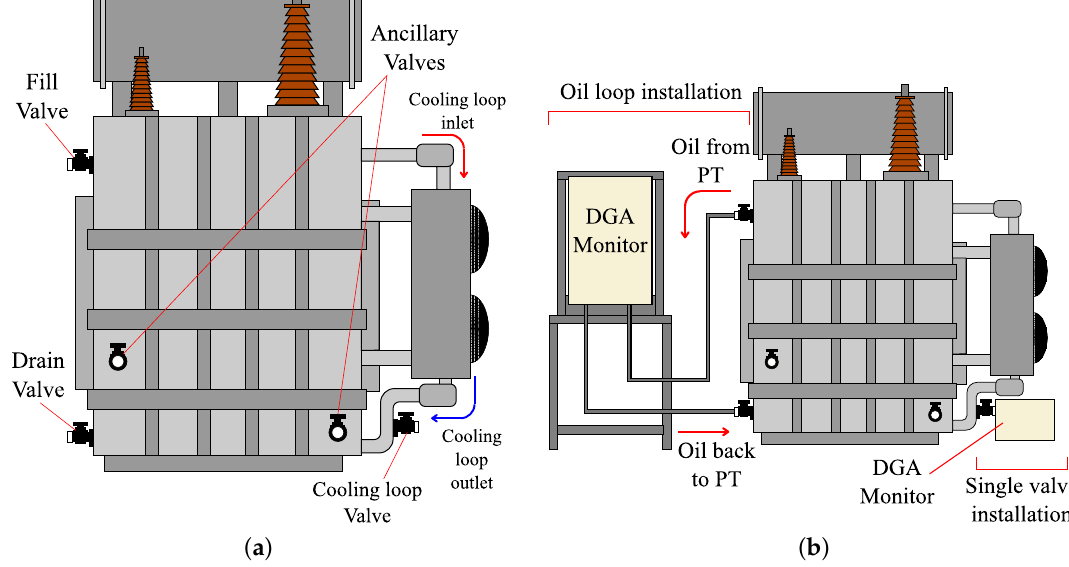
Figure 6. ( a ) Possible valve locations in a power transformer; and ( b ) installation schematic (Not to